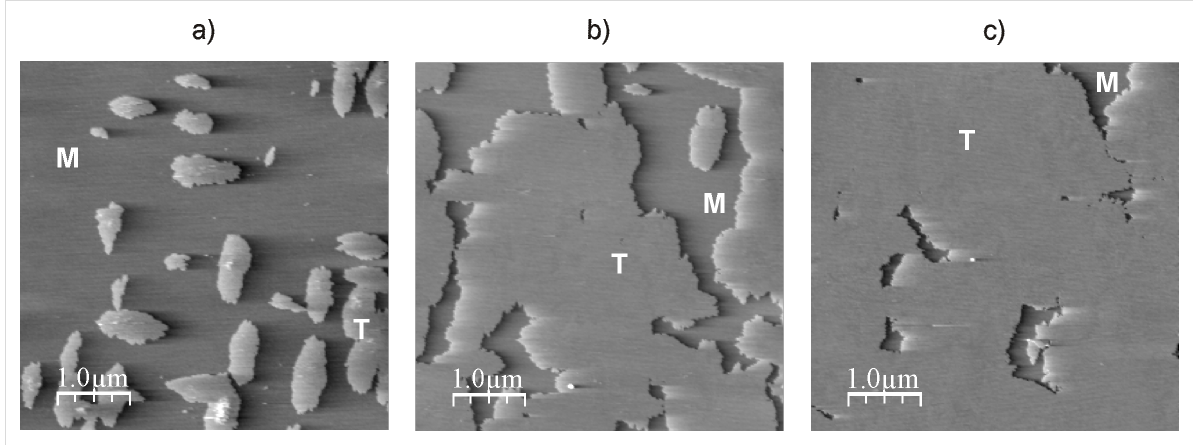
Figure 6: Growth of the tectomer formed by peptide Н -Gly 4 -NH( СН 2 ) 10 NH-Gly 4 - Н (concentration 0.1 mg/mL) on a mica surface in a liquid cell at рН 6.5. Phase SFM images were taken with a) t exp = 1 min, b) t exp = 2 min and c) t exp = 3 min where t exp is the time after the experiment was started. Т indicates the tectomer layer, M the uncovered mica